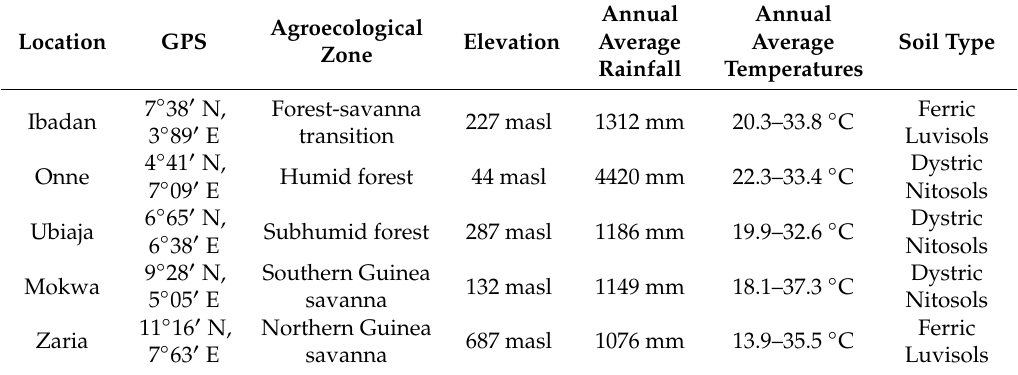
Table 1. Characteristics of the five trial growing